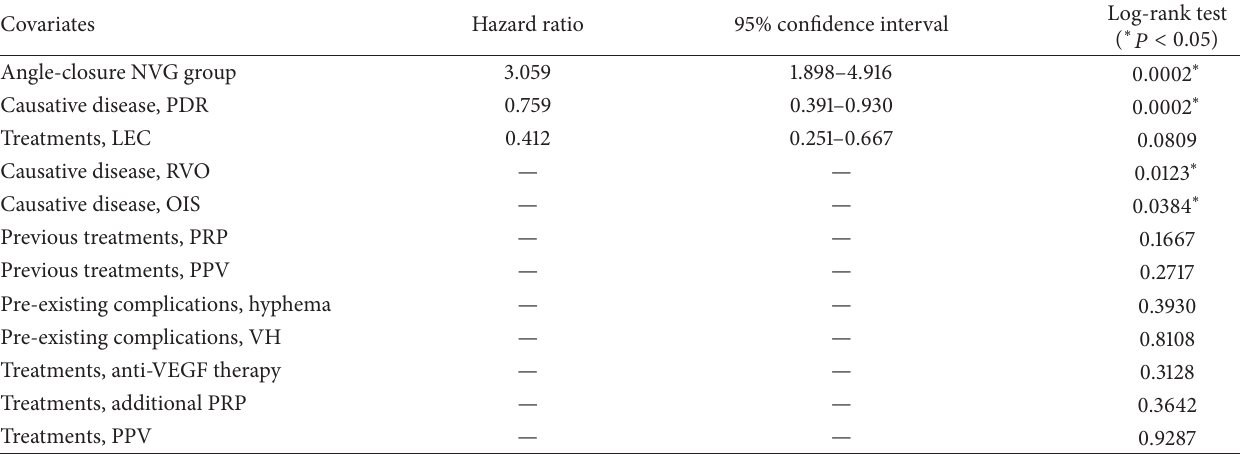
Table 3: Prognostic factors influencing final IOP in patients with NVG (multivariate statistics). Log-rank test and Cox proportional-hazards models were created to identify prognostic factors of NVG using final IOP > 21mmHg as the study end-point. Angle-closure was associated with a 3-fold worsening in NVG-IOP prognosis. Patients with NVG with PDR had relatively better prognosis than those with NVG induced by other